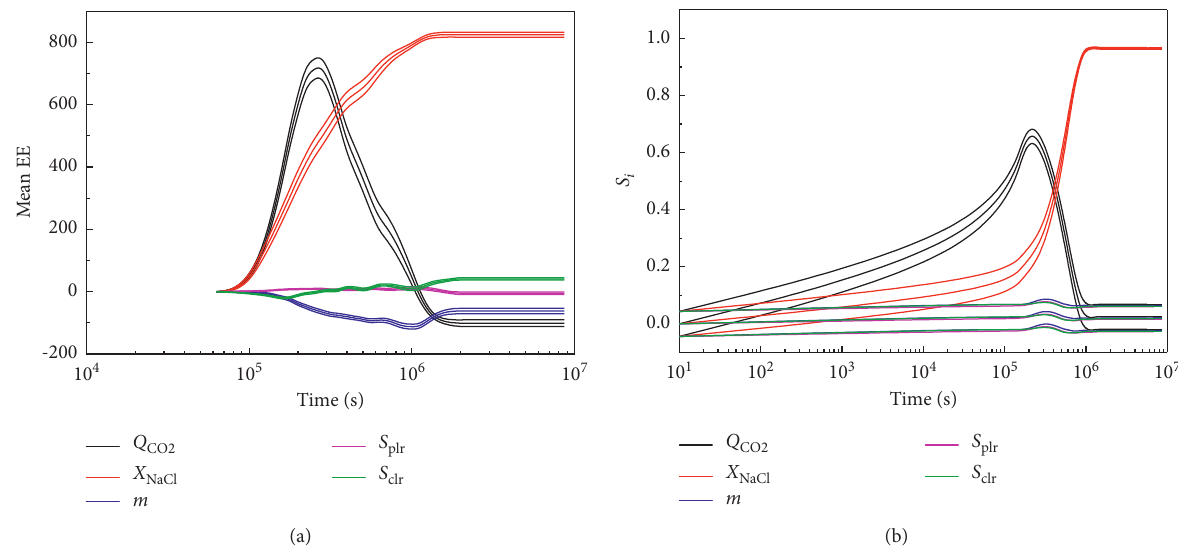
Figure 6: Time evolution of sensitivity index: (a) mean EE; (b) S